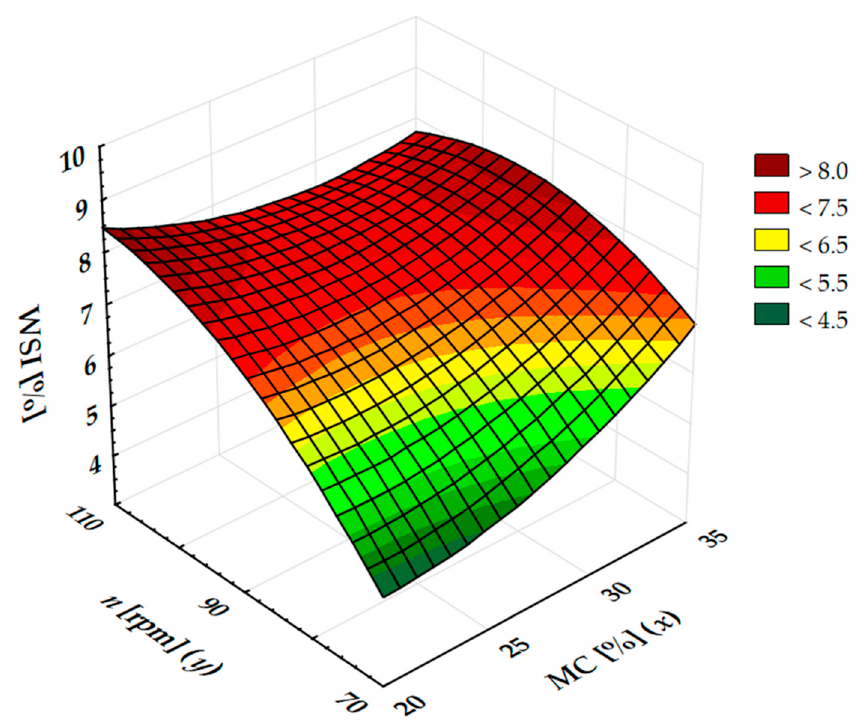
Figure 5. The influence of the rotational speed of the extruder screw and the level of raw mate- rial moisture on the water solubility index ( WSI). moisture on the water solubility index ( WSI